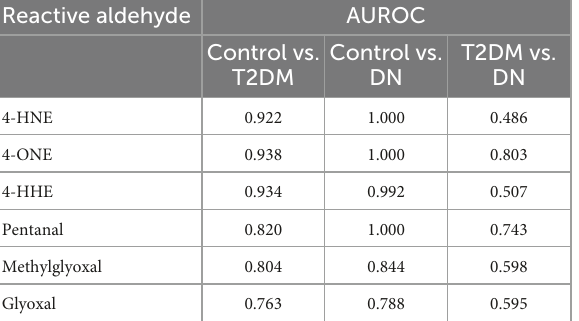
TABLE 6 Area under the receiver operator characteristic comparing plasma reactive aldehydes: Control vs. type-2 diabetic mellitus (T2DM), control vs. diabetic nephropathy (DN), and T2DM vs. DN. Reactive